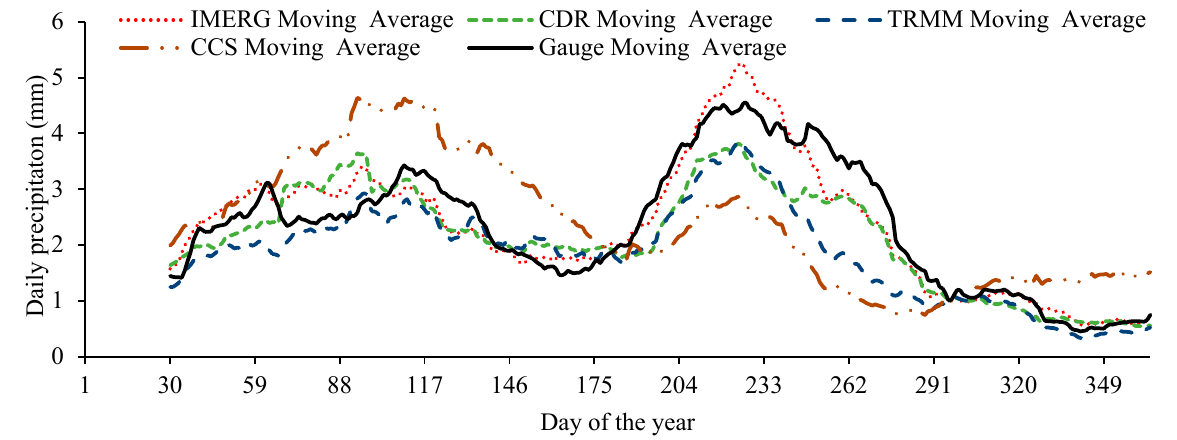
Figure 5. Temporal variability of all SBPD and gauge estimation.